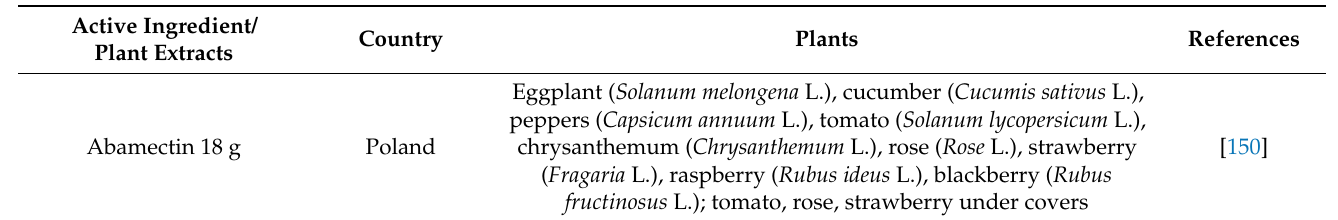
Table 2. Plant protection products formulated on natural extracts from plants used for treatment T. urticae